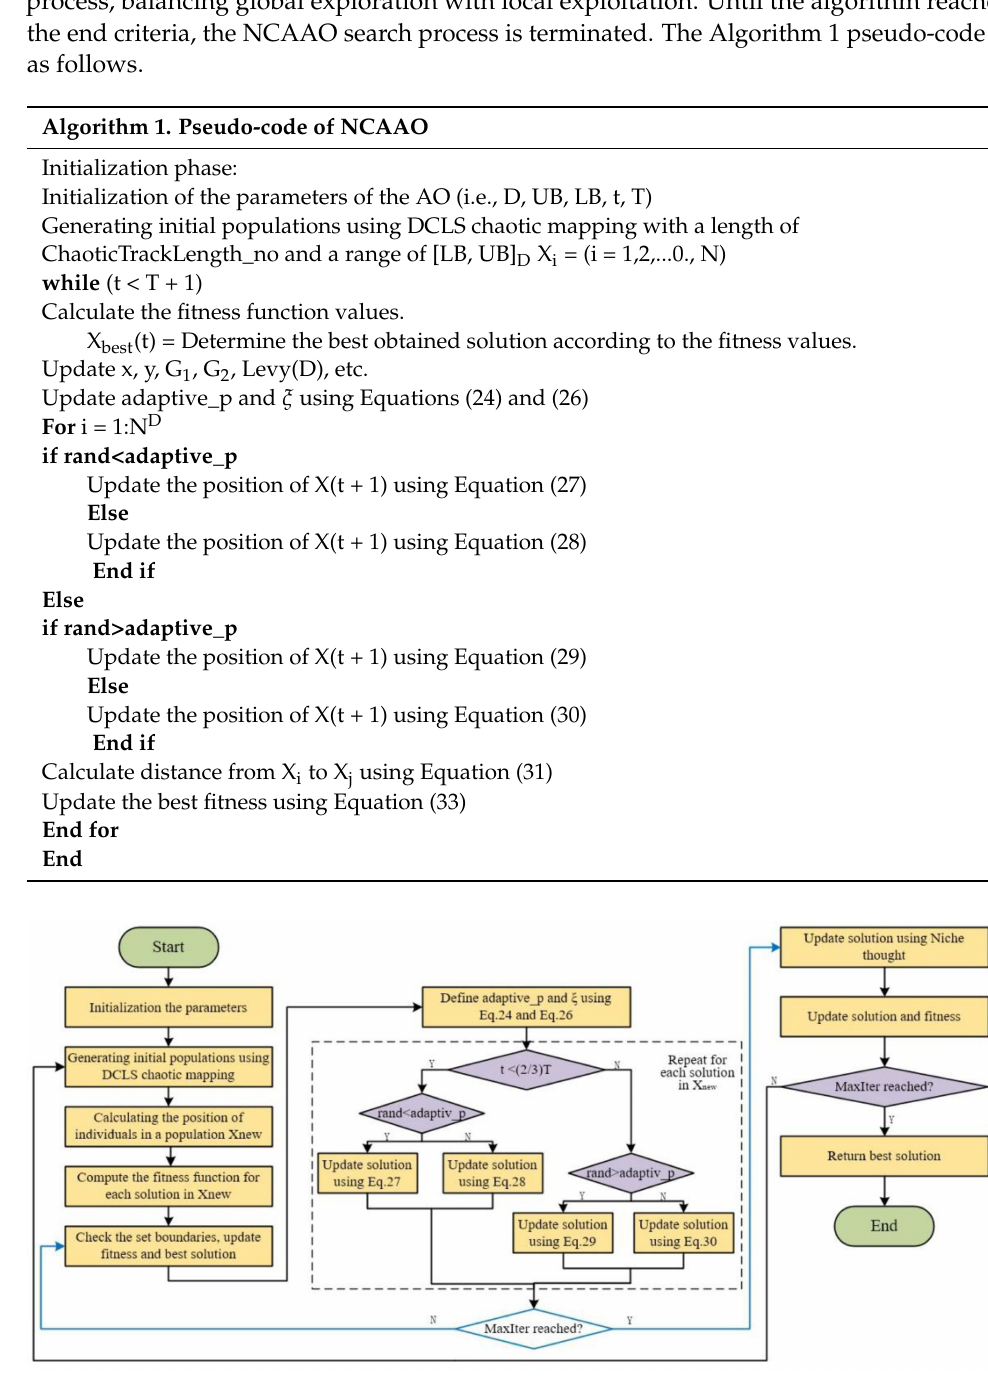
Figure 4. NCAAO algorithm flow